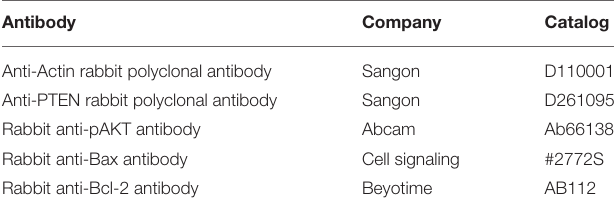
TABLE 1 | Primary antibodies used in this